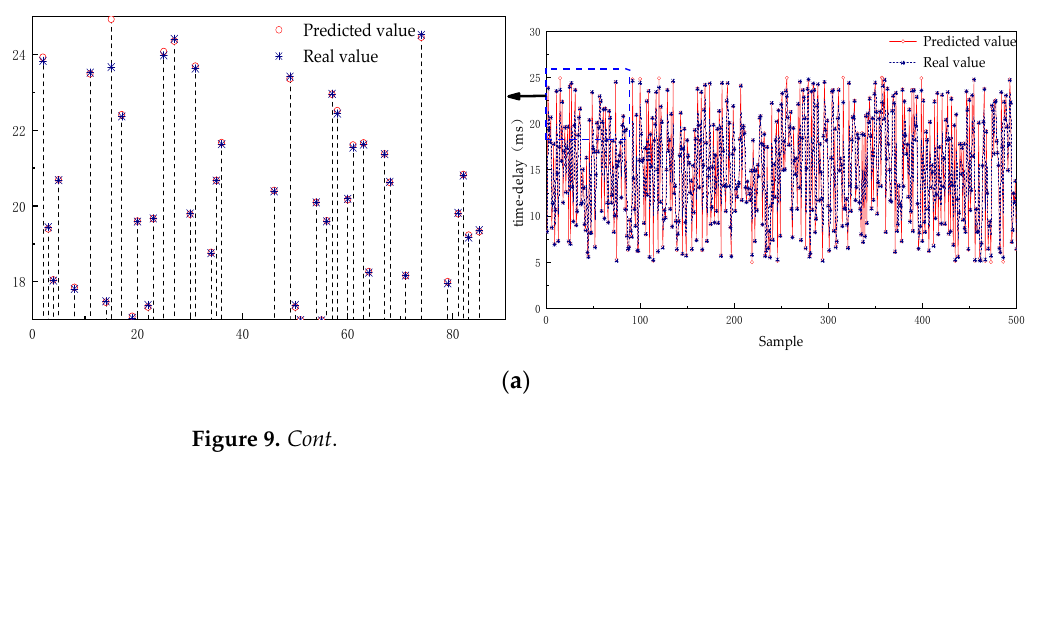
Figure 8. Comparison of Optimal Search by PSO Algorithm Based on weight adjustment formulas.